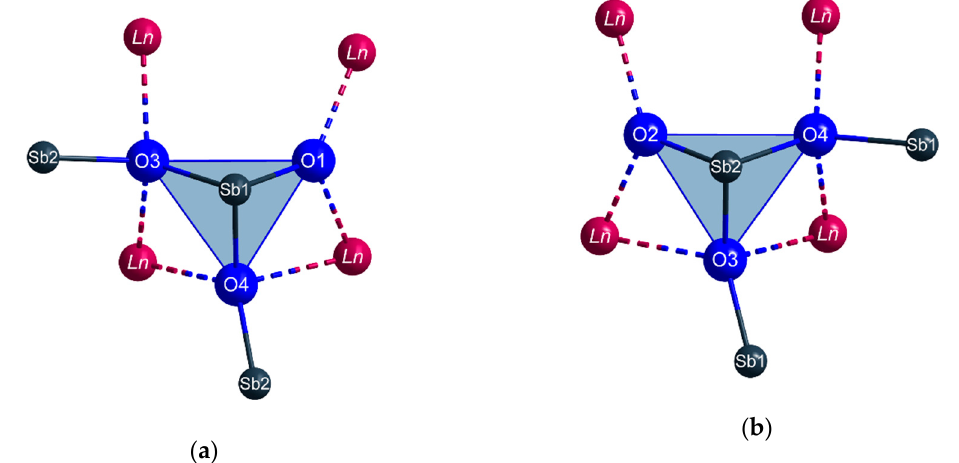
Figure 3. The first and second coordination spheres of the two crystallographically different Sb 3+ cations ( a ): Sb1, ( b ): Sb2) in the crystal structure of the Ln Sb 2 O 4 Br series ( Ln = Eu ‒ Tb) with vertex-connected [SbO 3 ] 3 ‒ ψ 1 -tetrahedra as dominant structural feature.